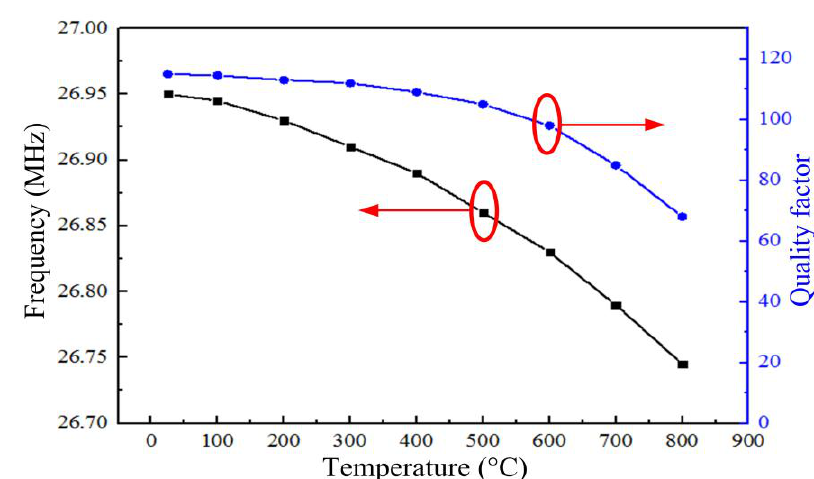
Figure 9. Resonant frequency f 0 and quality factor Q of the sensor as a function of